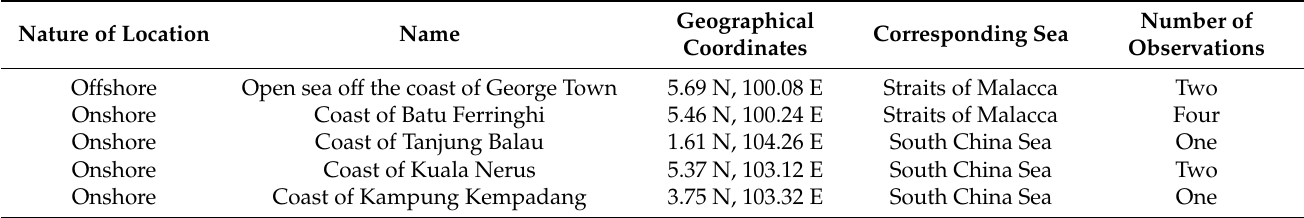
Figure 2. ( a ) Data collection sites across West Malaysia, offshore site is highlighted by blue marker; ( b ) ship route during open sea data collection experiment. Table 3. Details of geographical locations selected for